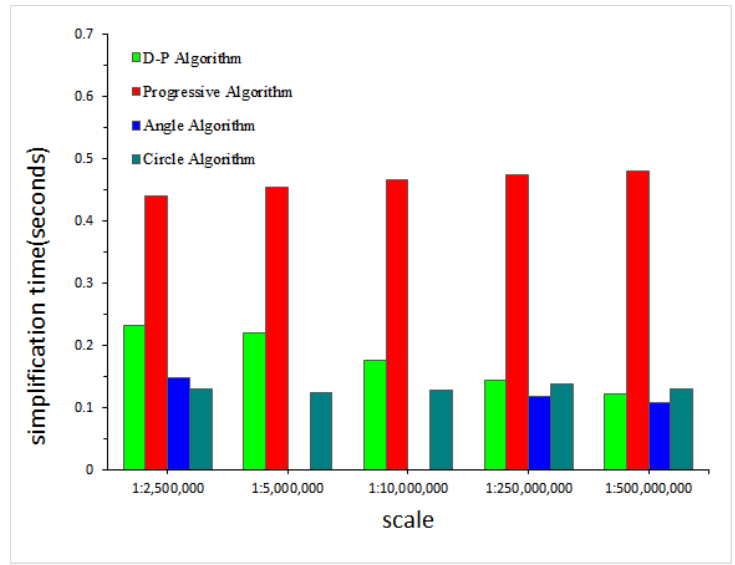
Figure 10. The simplification times required by the four simplification algorithms.